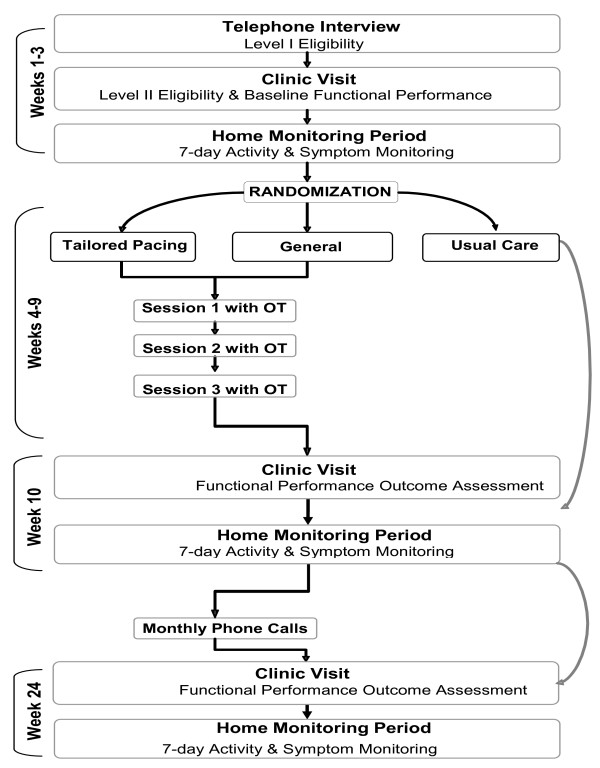
Study Flow Chart.